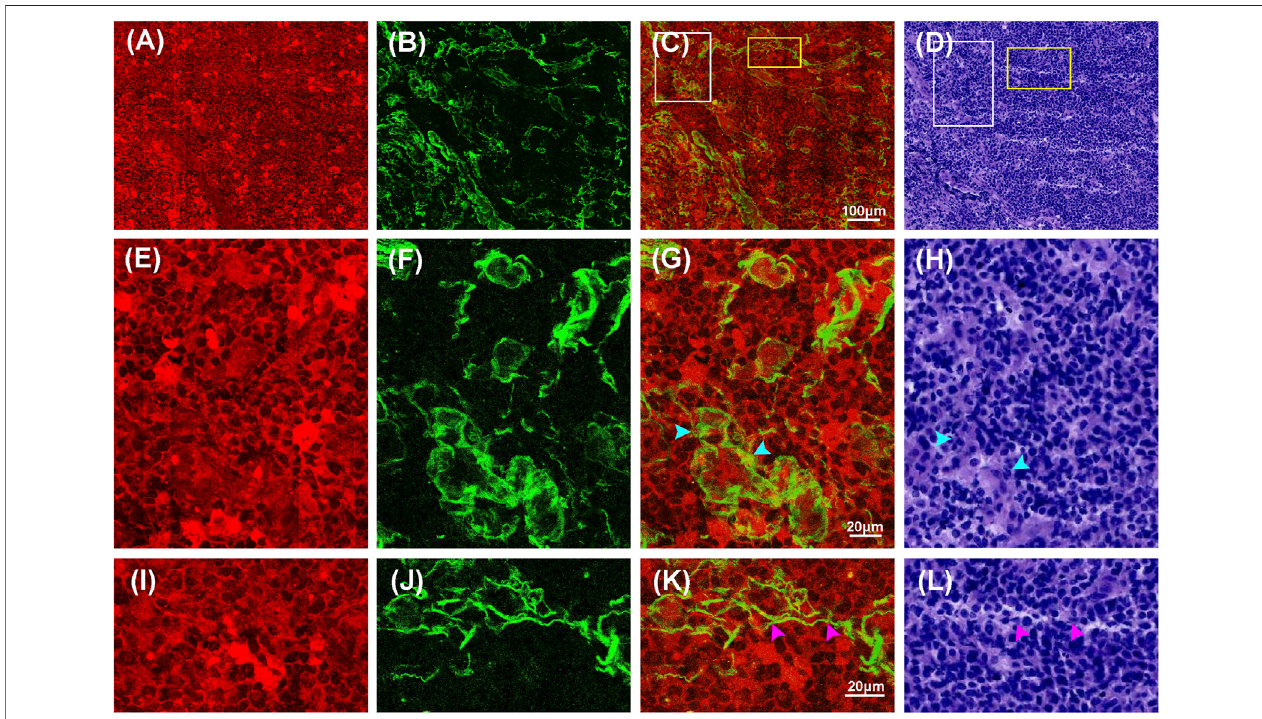
FIGURE 5 | Representative MPM images and the corresponding H&E stained images of high-grade glioma (tumor central region). (A – D) TPEF, SHG, TPEF/SHG overlaid and corresponding H&E image of high-grade glioma. (E – H) The magni fi ed TPEF, SHG, TPEF/SHG overlaid images, and corresponding H&E image of the selected area (white square box) in Figure 5C . (I – L) The magni fi ed TPEF, SHG, TPEF/SHG overlaid images, and corresponding H&E image of the selected area (yellow square box) in Figure 5C . Cyan arrowheads: blood vessels in high-grade glioma; pink arrowhead: collagen in high-grade glioma.